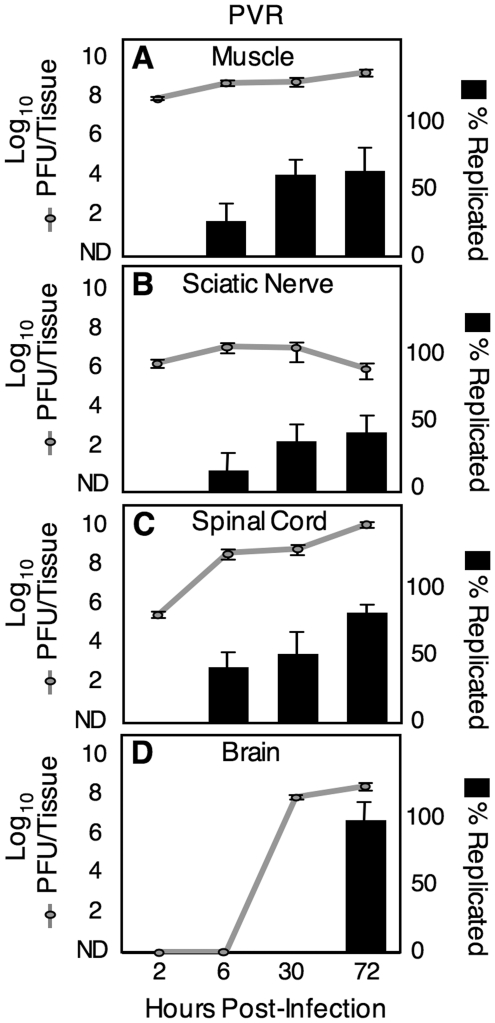
Viral replication kinetics.Mice were intramuscularly inoculated with 2×107 PFU of light-sensitive/neutral red poliovirus in the dark, tissues were harvested at 2, 6, 30 and 72 hpi in the dark, and virus was extracted in the dark. Half of the virus sample for each tissue was exposed to light (inactivating non-replicated viruses, to quantify replicated viruses), and half was maintained in the dark (to quantify all viruses). Virus in light-exposed and non-exposed samples was quantified by plaque assay. Total titer represents titer from non-light-exposed sample and is expressed as PFU/tissue (grey lines). Therefore, the grey lines represent titer from inoculum virus plus replicated virus. The percent of replicated viruses was obtained by dividing the light-exposed titer by the non-light-exposed titer for each individual sample (black bars). Mean with SEM from 3–7 mice is shown.